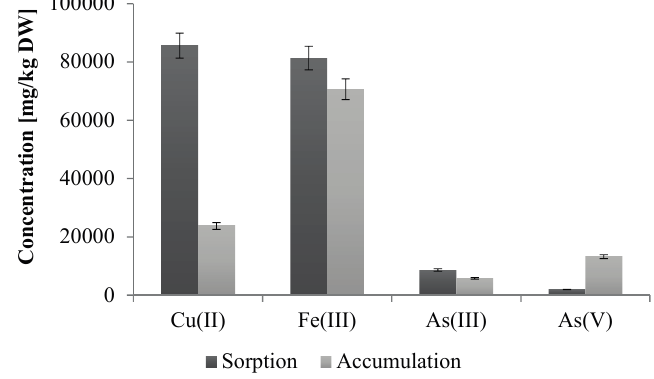
Figure 4. Efficiency of heavy metal sorption (passive process) and accumulation (living biomass) by the cells of Shewanella sp. O23S. At the beginning of both experiments the concentration of As(III), As(V), Cu(II), and Fe(III) was 2 mM and the pH of each metal solution was 7.